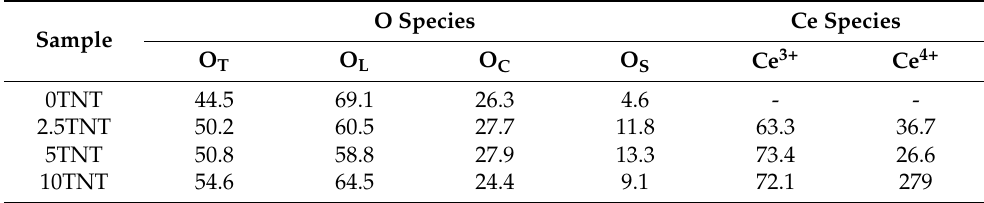
Table 3. Quantitative analysis of O and Ce ions of the TNT samples, mol%. Sample